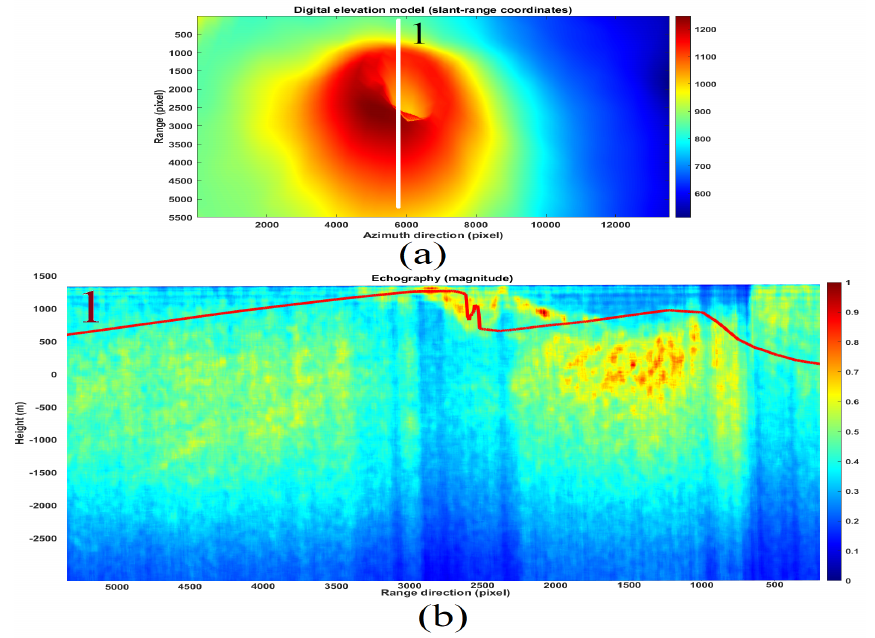
Figure 16. Range-line echographic tomography result (magnitude), and validation through DEM. ( a ) DEM results in the slant-range coordinates. ( b ) Tomographic map (in magnitude), and topographic height (yellow line). The result is calculated over the white line drown on the DEM reported in Figure ( a ). The yellow tomographic line is indicated by the number